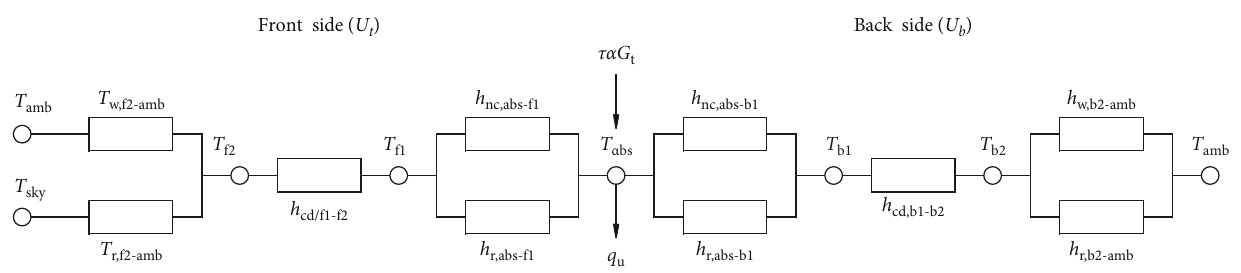
Figure 2: The thermal network of external energy balance if Operating Mode is equal to 0 — a liquid collector.